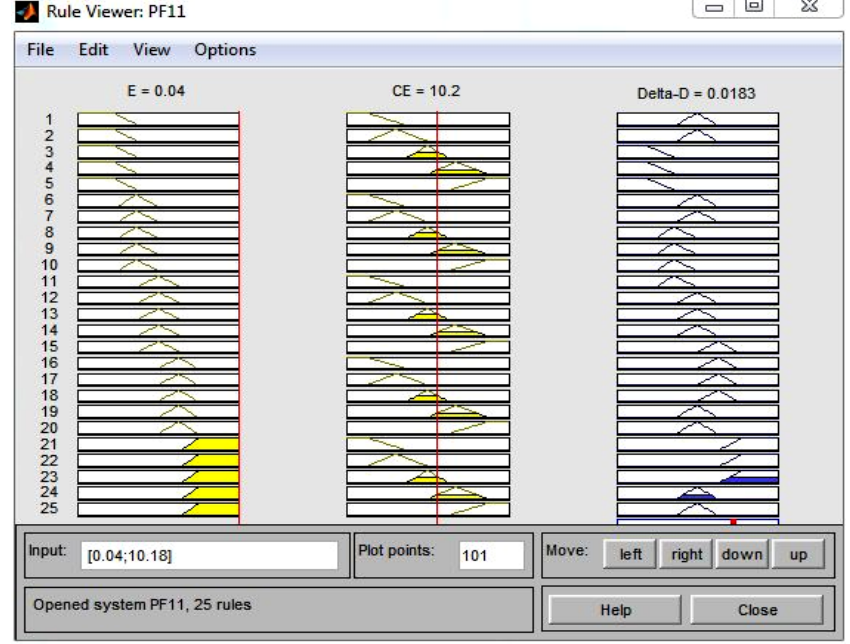
Figure 6. Rule viewer of fuzzy logic controller (FLC) system.